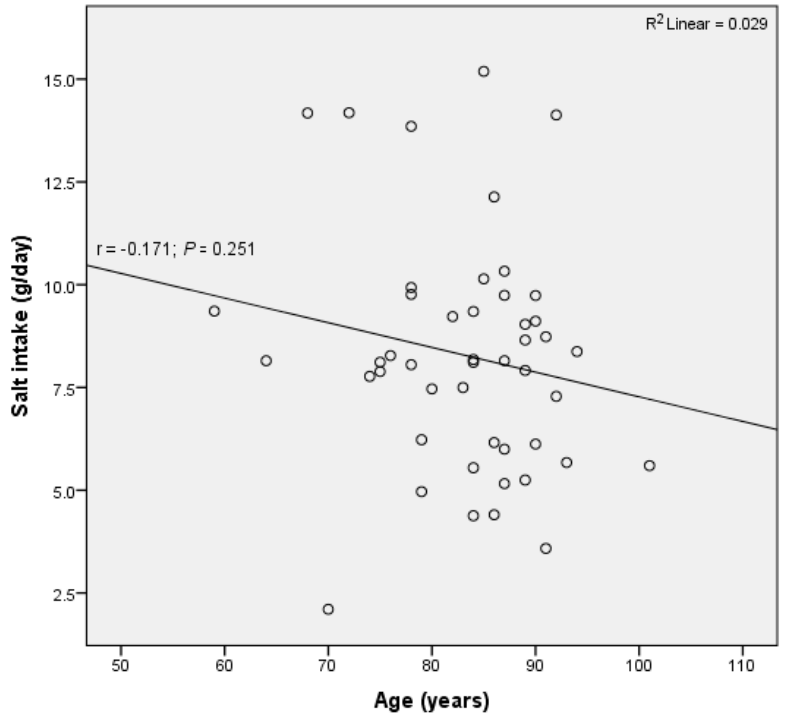
Figure 5. No significant correlation between daily salt intake and age was observed in residents of retirement homes in Goriška region.